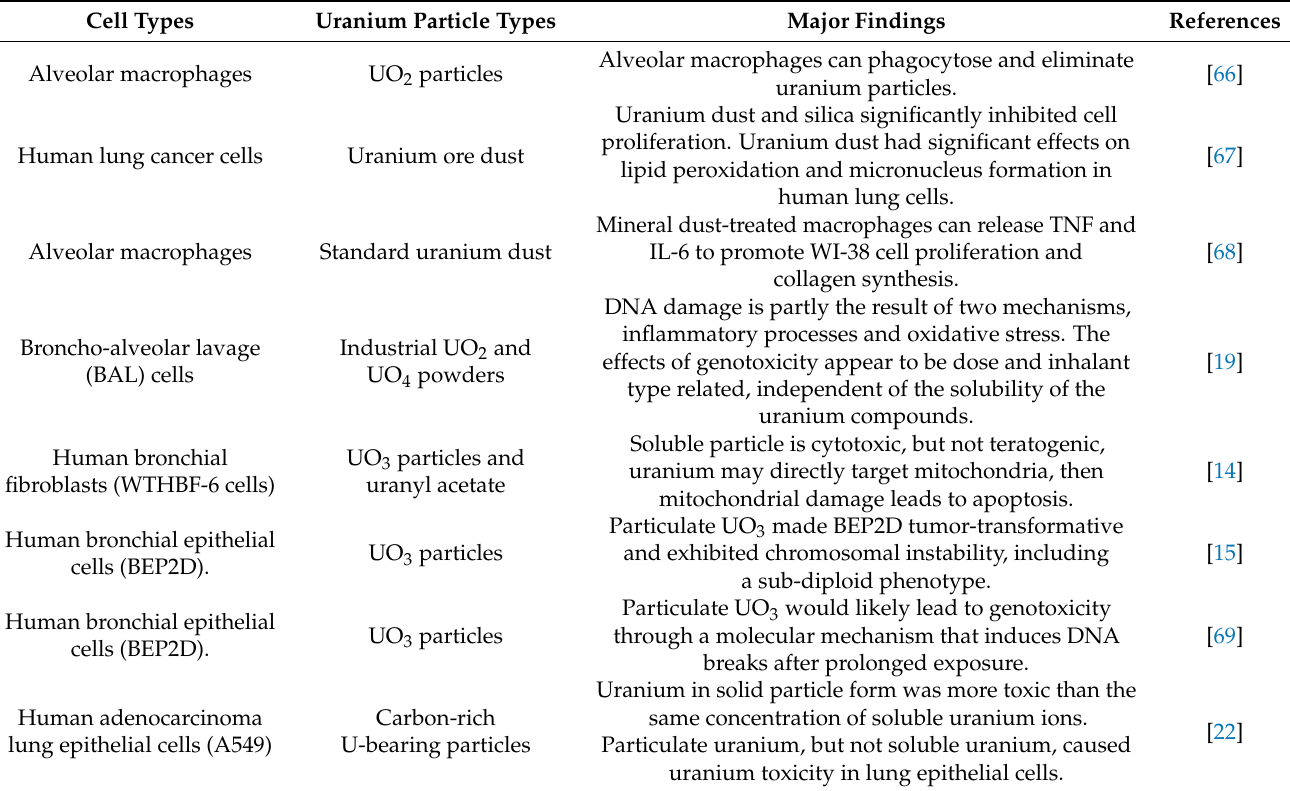
Table 2. In vitro studies of biological mechanisms exposure to particulate